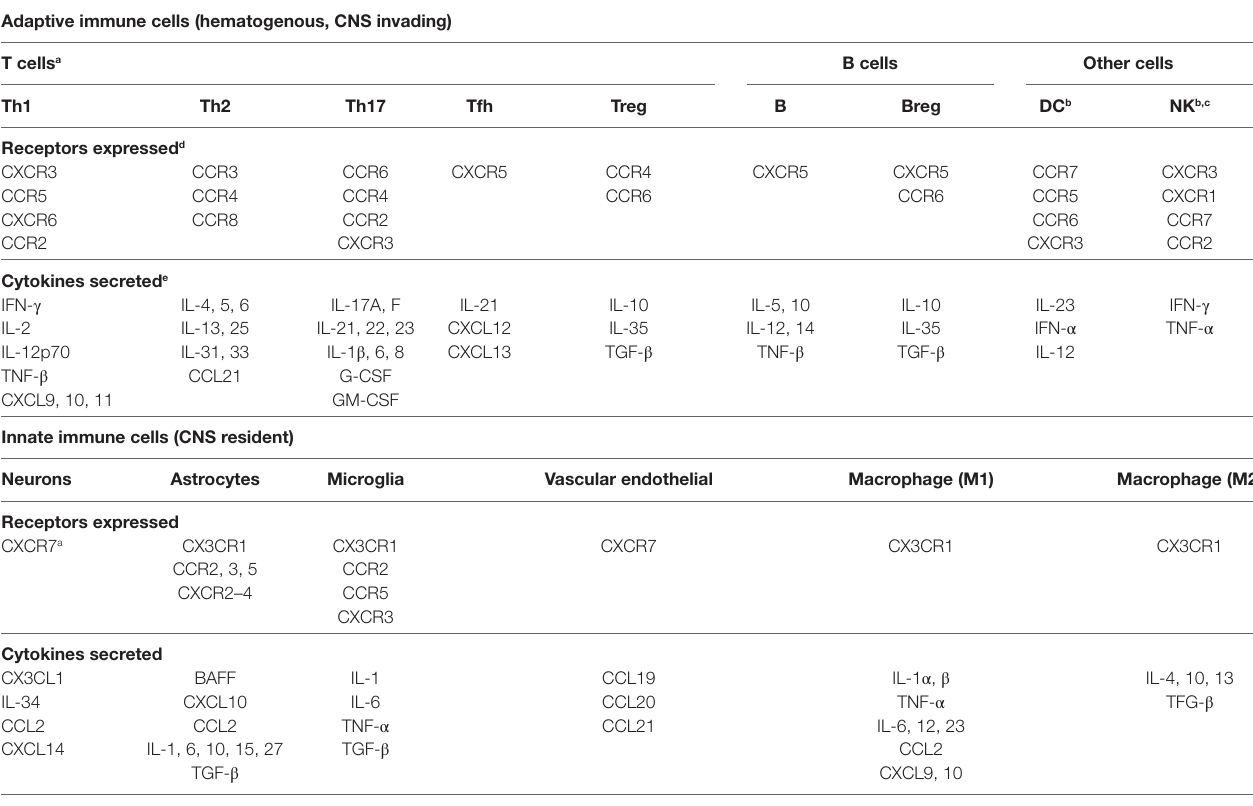
TABle 4 | Chemokine receptor (CKR) expression and cytokine production by type of immune cell. Adaptive immune cells (hematogenous, CNS invading) T cells a B cells Other